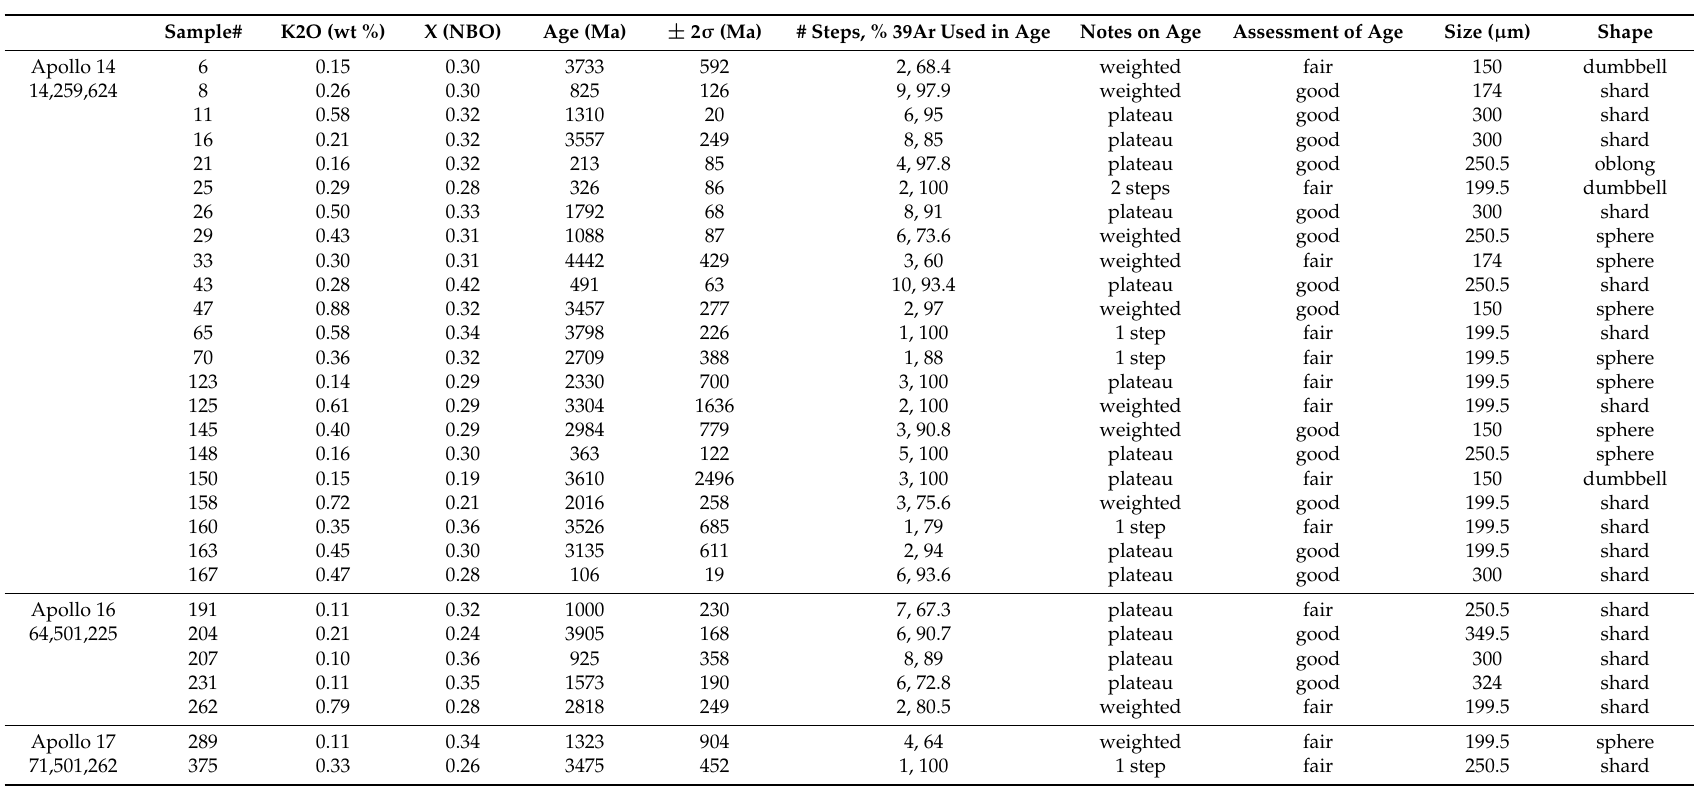
Table 1. K 2 O (wt%), X(NBO), and age data for Apollo 14, 16, and 17 lunar impact glasses for good or fair glasses. "ND" means not determined. Assessment of argon release patterns are ‘good’ if >50% 39 Ar was used in the age and most of the steps were concordant; ‘fair’ if some of the steps were concordant; and ‘poor’ if none of the steps were